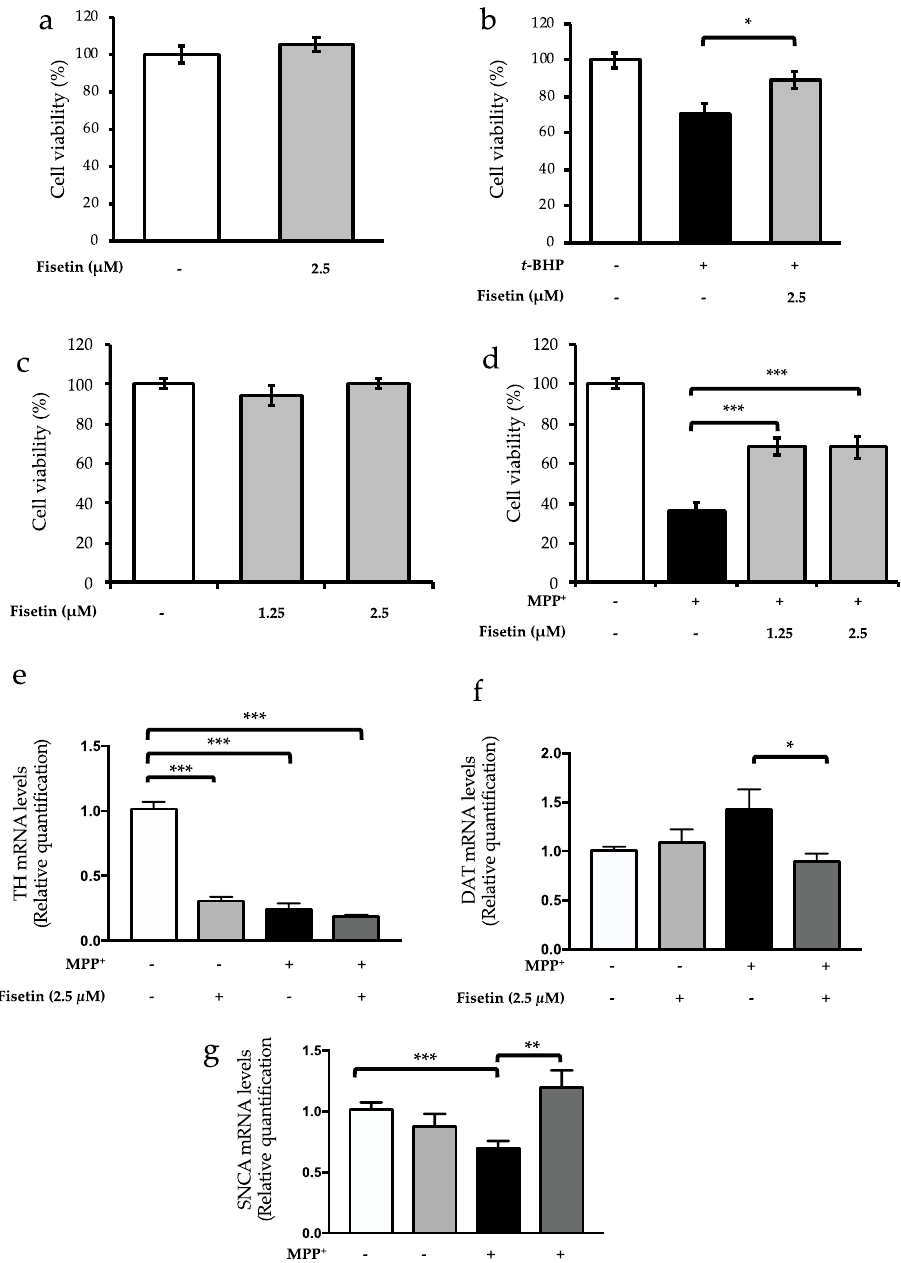
Figure 1. Fisetin rescues neuronal cells from oxidative insults. ( a ) SH-SY5Y cells were treated or not with 2.5 µM of fisetin for 6 h, and cell viability was assessed using CellTiter Blue ® Cell Viability Assay kit. ( b ) SH-SY5Y cells were pretreated or not with 2.5 µM of fisetin for 6 h and then challenged with 35 µM of t -BHP for 18 h. ( c ) LUHMES cells were treated or not with fisetin (1.25 or 2.5 µM) for 24 h, and cell viability was assessed using CellTiter Blue ® Cell Viability Assay kit. ( d ) LUHMES cells were pretreated or not with fisetin (1.25 or 2.5 µM) for 24 h and then challenged with 5 µM of MPP + for 24 h. Cell viability was assessed using CellTiter Blue ® Cell Viability Assay kit. ( e ) Tyrosine hydroxylase (TH), ( f ) dopamine transporter (DAT), and ( g ) α-synuclein (SNCA) mRNA levels in LUHMES were assessed by qRT-PCR using HPRT1, GAPDH, and B2M as reference genes. The values represent the mean ± SEM of at least three biological replicates. Statistic differences are denoted by * p < 0.05, ** p < 0.01, and *** p < 0.001 vs. indicated condition.